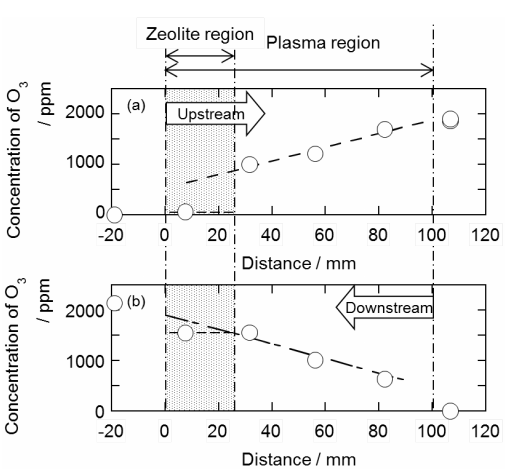
Figure 4. Relationship between the decomposition efficiency and the adsorption of ozone: ( a ) upstream configuration and ( b ) downstream configuration.